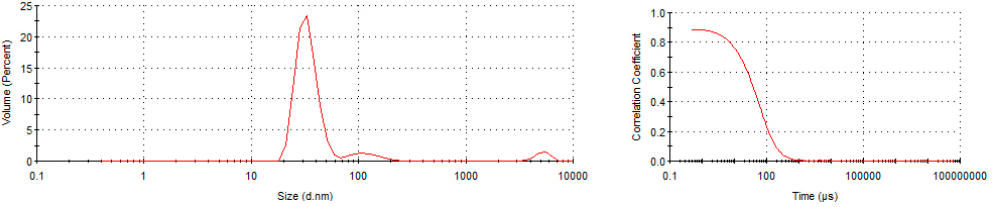
Figure 2. Volume weighted particle size distribution ( Left ) and corresponding correlation curve ( Right ) of sol 12 .